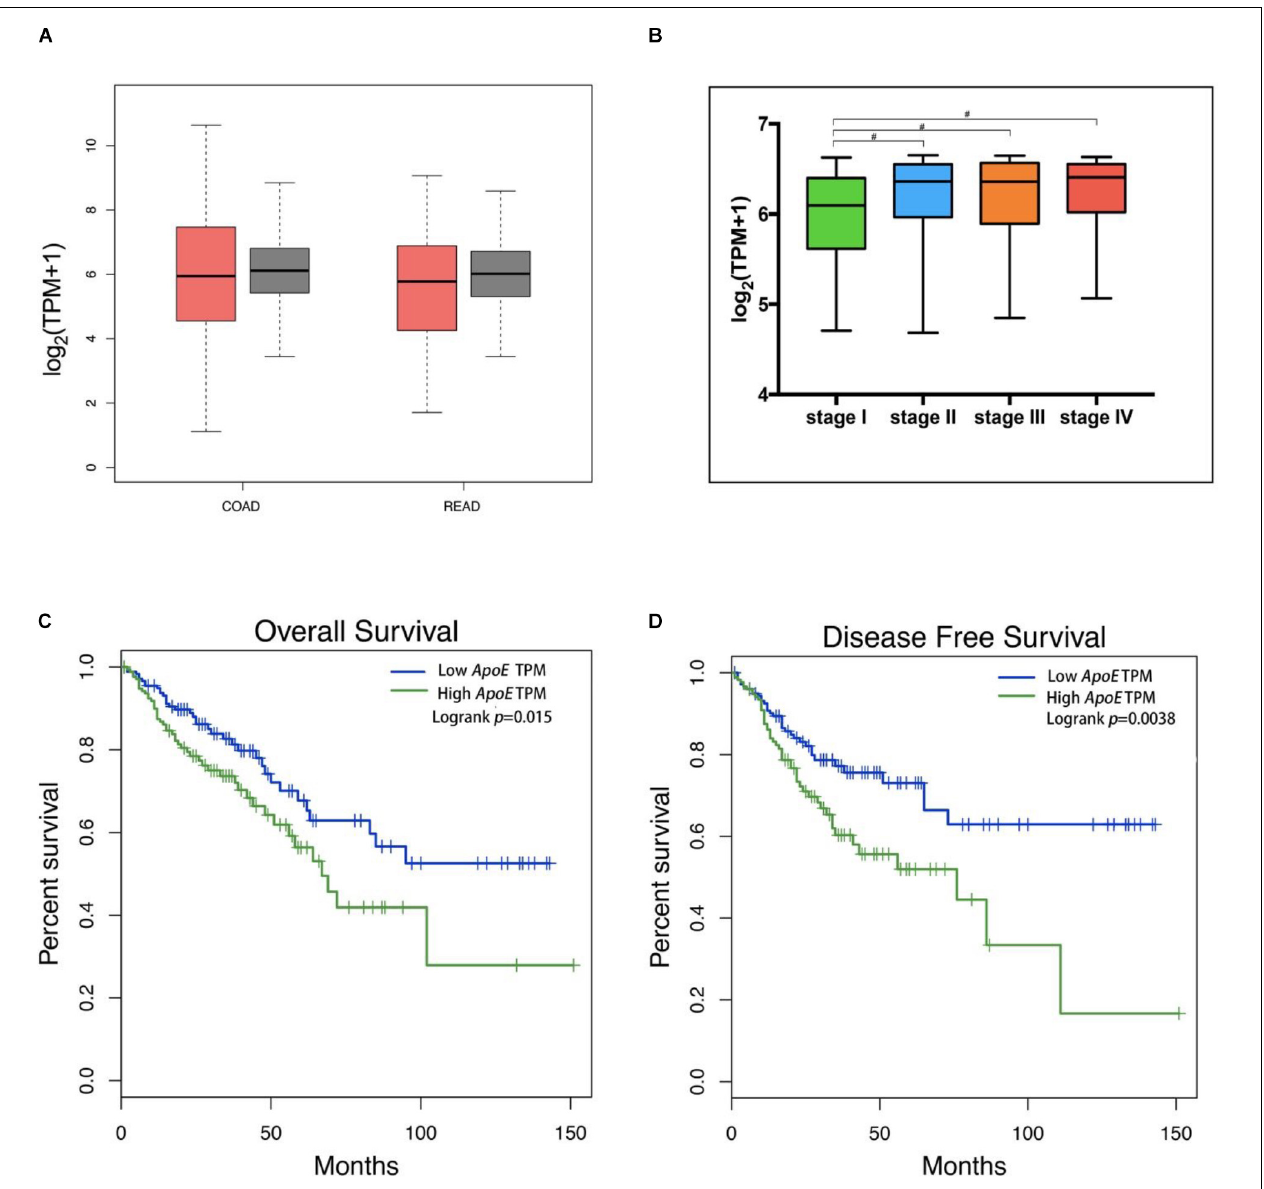
FIGURE 3 | Expression of the ApoE protein in CRC and Kaplan–Meier Curves based on TCGA database. The tumor was represented by red color and the normal tissue was represented by gray color (A) . The ApoE expression box plots were generated based on CRC patient pathological major TNM staging (B) . The most extreme value from bottom to top in the box plot represents minimum value, the lower quartile, the median, the upper quartile and the maximum value. The method for differential gene expression analysis is one-way ANOVA, using the pathological stage as a variable for calculating differential expression. The ApoE high expression group was associated with decreased overall survival (C) and disease-free survival (D) in CRC according to the data from TCGA, which were calculated using a log-rank test. CRC, Colorectal cancer; TPM, transcript per million; # Represents p -value <